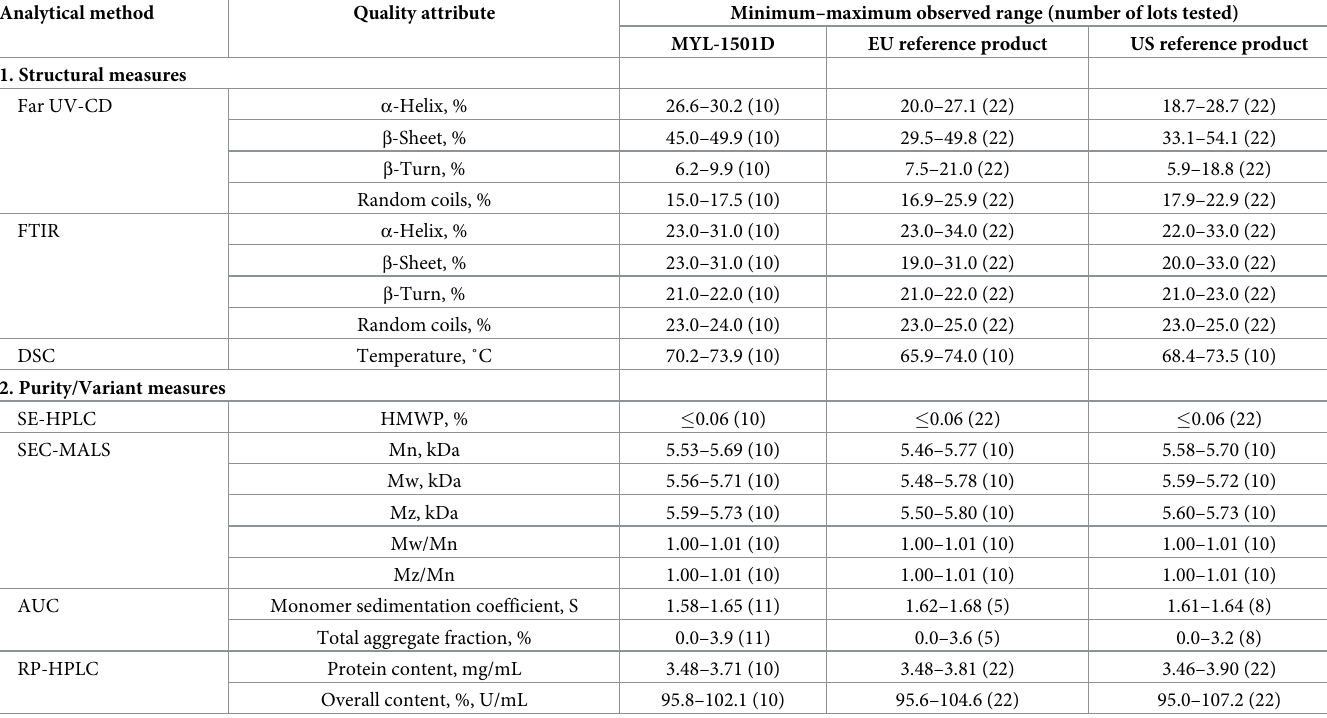
Table 2. Structure and purity/variant physicochemical studies of MYL-1501D and US and EU reference products. Analytical